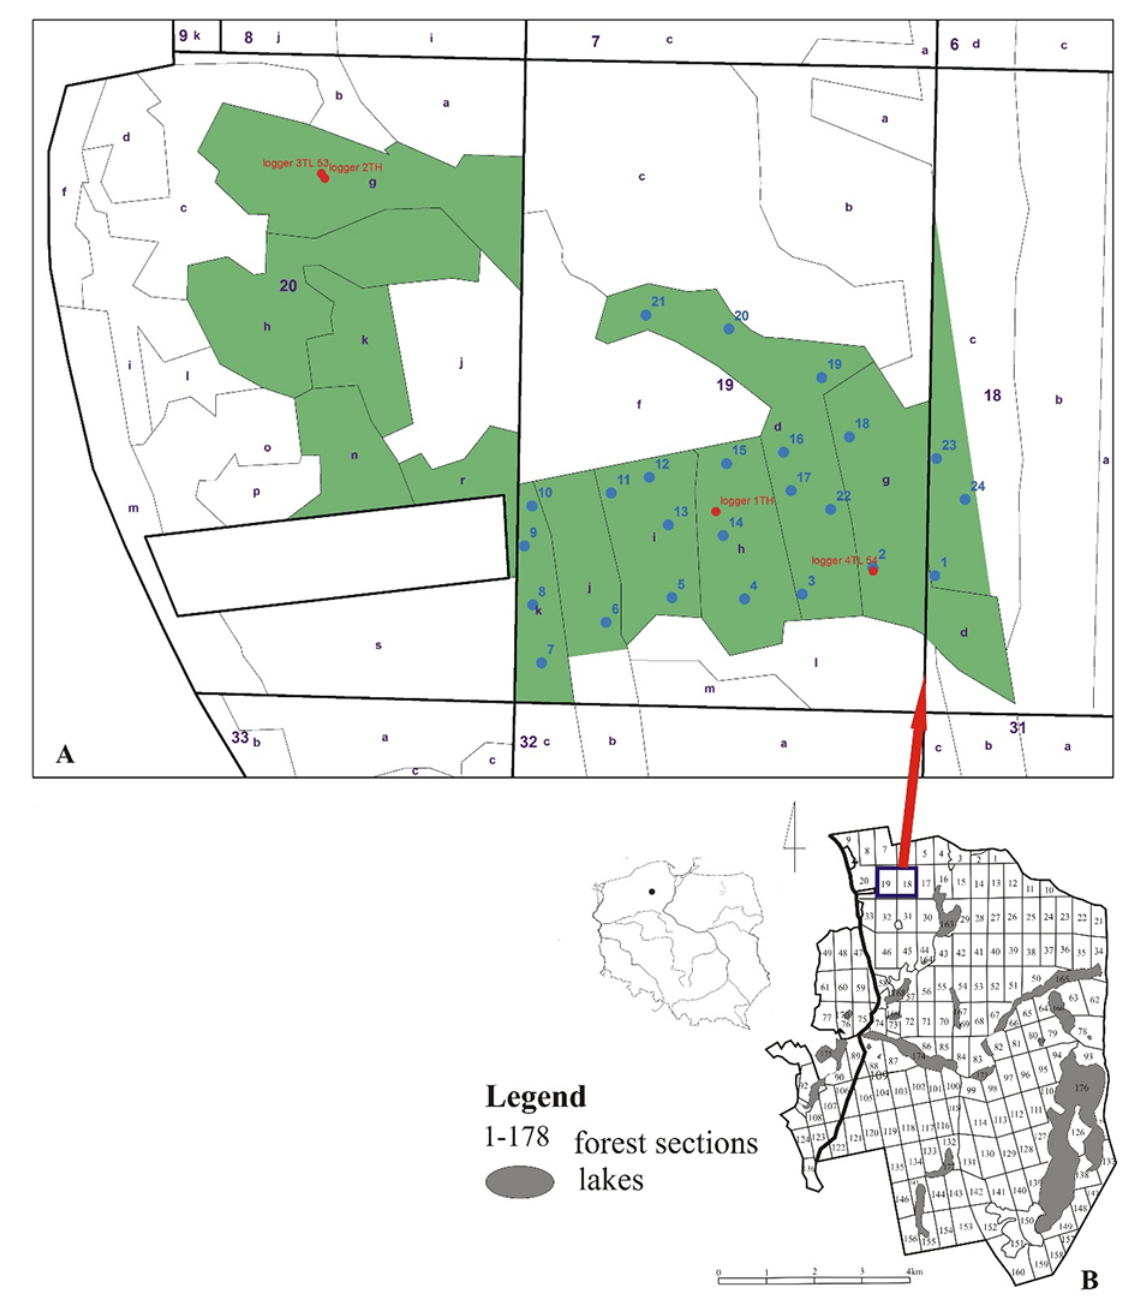
Figure 1 ( A ) Location of permanent plots (blue, numbered 1–24) and loggers (red). The numbers and small letters (purple) indicate forest sections and forest subsections. Areas in green are areas of Cladonio-Pinetum designated by experts for active protection procedures. ( B ) Location of forest sections in the area of “Bory Tucholskie” National Park. Map in ( A ) was prepared by Agnieszka Turowska; map in ( B ) is modified from Grzesiak, Kochanowska, and Kochanowski